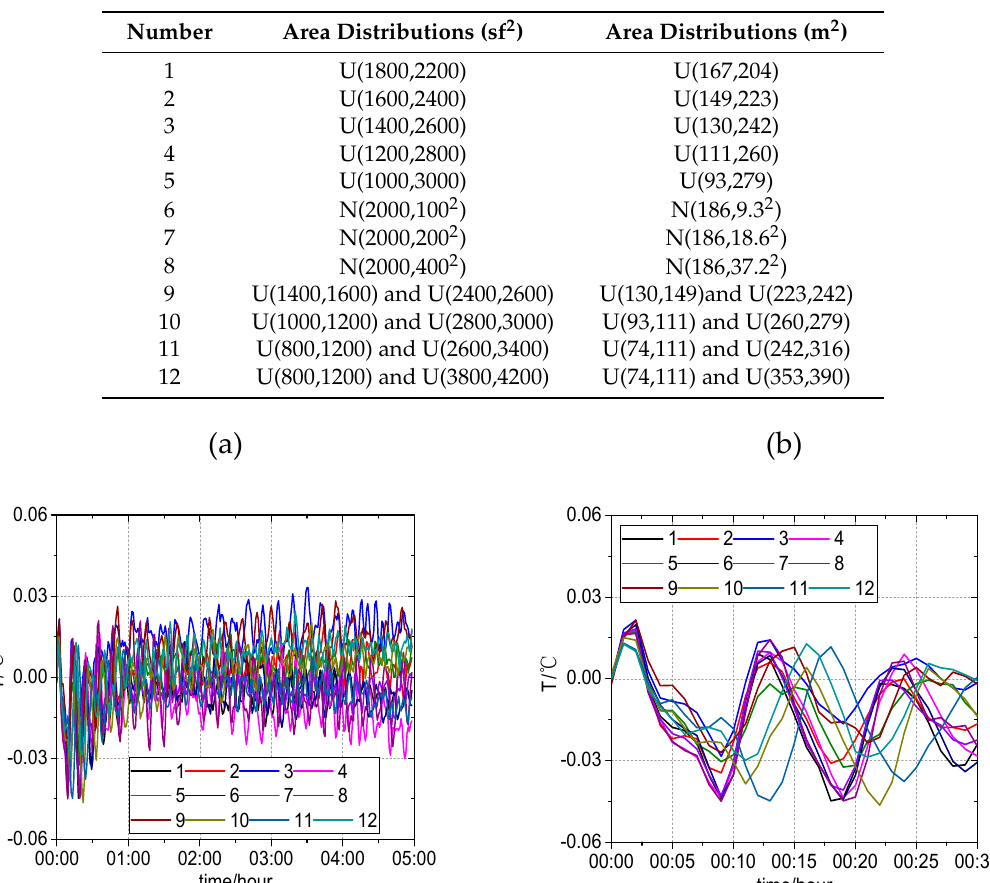
Figure 4. The average indoor temperature difference. ( a ) Temperature differences from 0 to 5 hours; ( b ) temperature differences from 0 to 30 min.